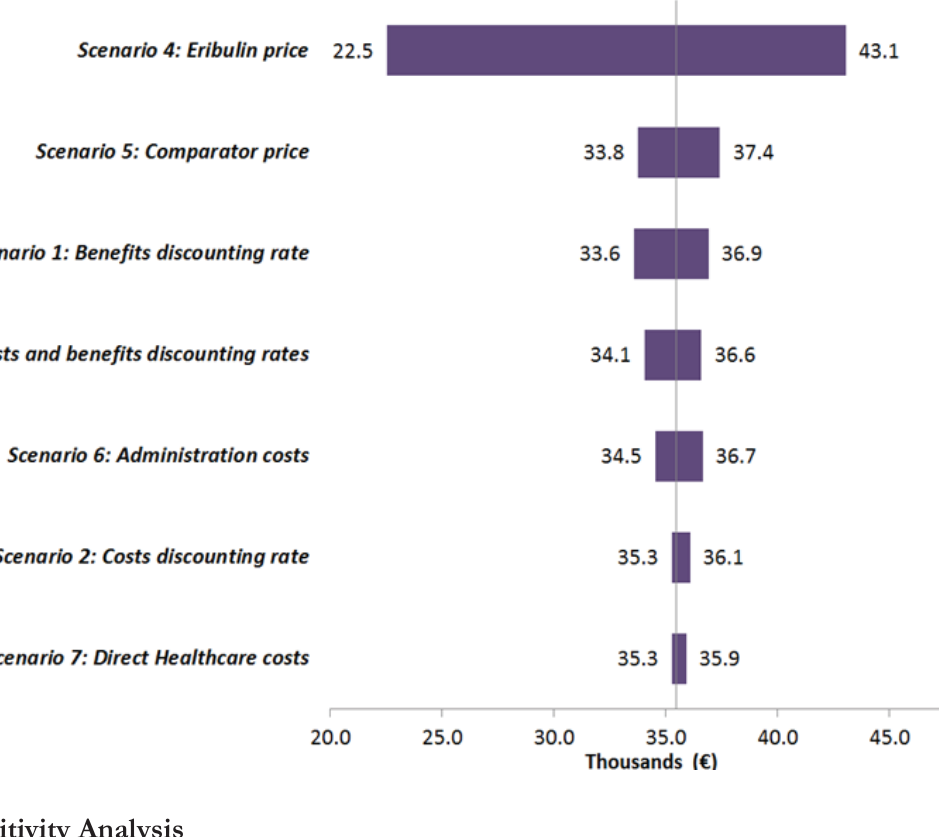
Figure 3. Tornado Graph of Deterministic Sensitivity Analysis Results (ICER per QALY) for Postcapecitabine Patients receiving Third-line